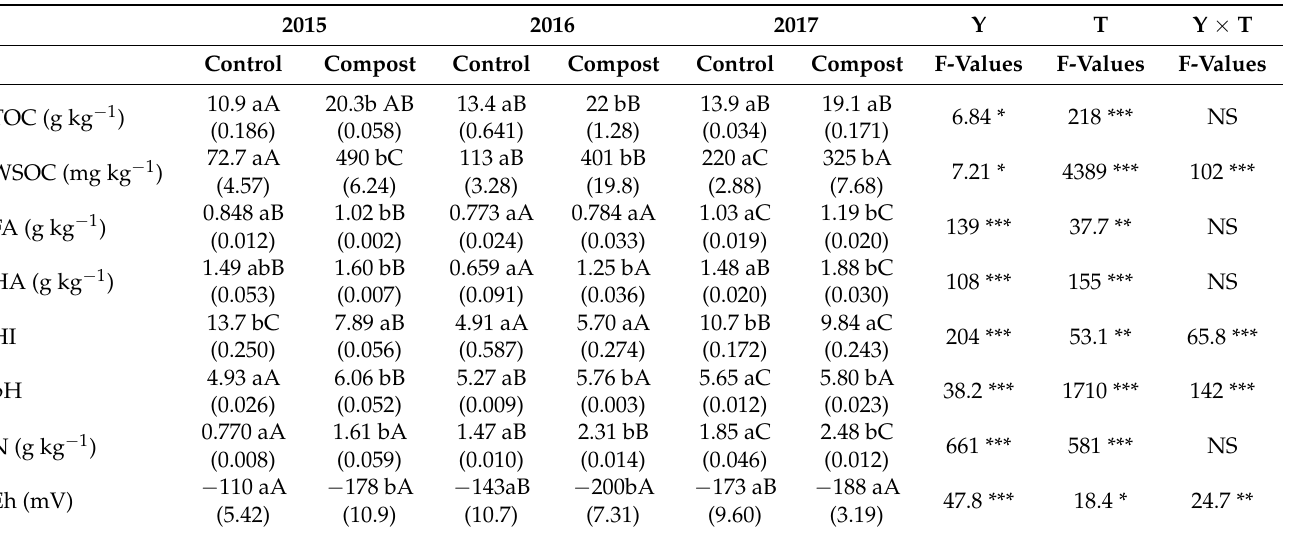
Table 1. Effects of different management systems on soil physicochemical properties (0–20 cm depth). Mean value and standard error of 3